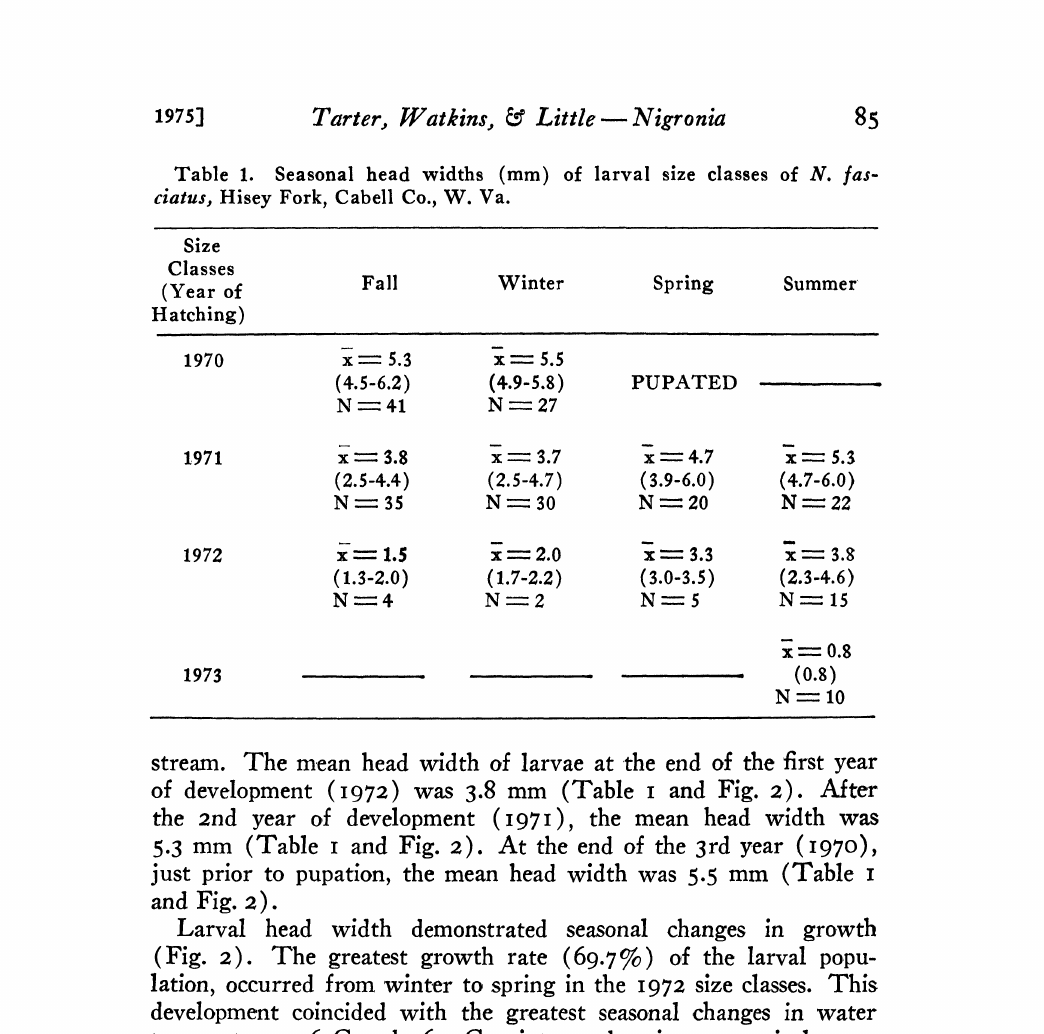
Table 1. Seasonal head widths (mm) of larval size classes of N. fas- ciatus, Hisey Fork, Cabell Co., W.